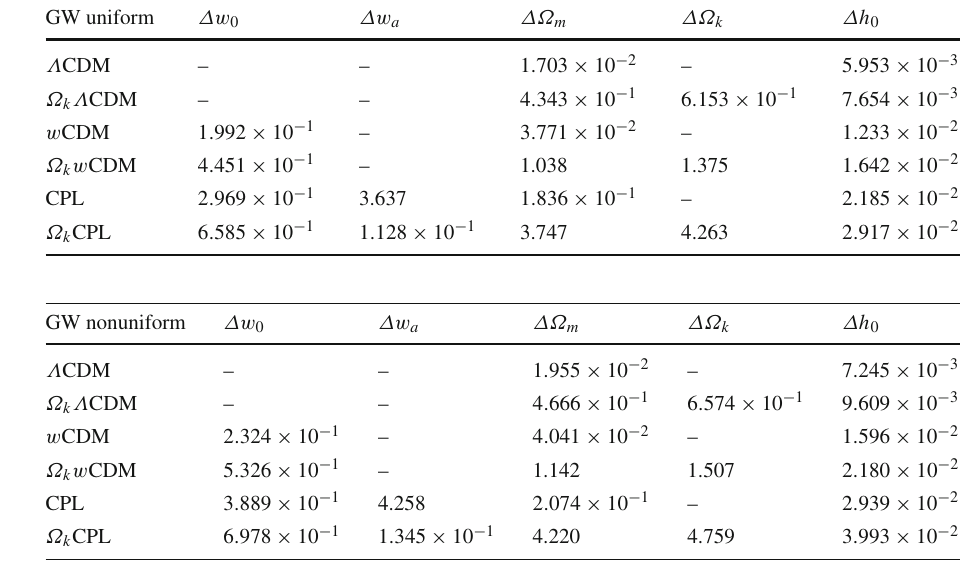
on cosmological parameters from the ET GWs for the uniform distribution of GW sources